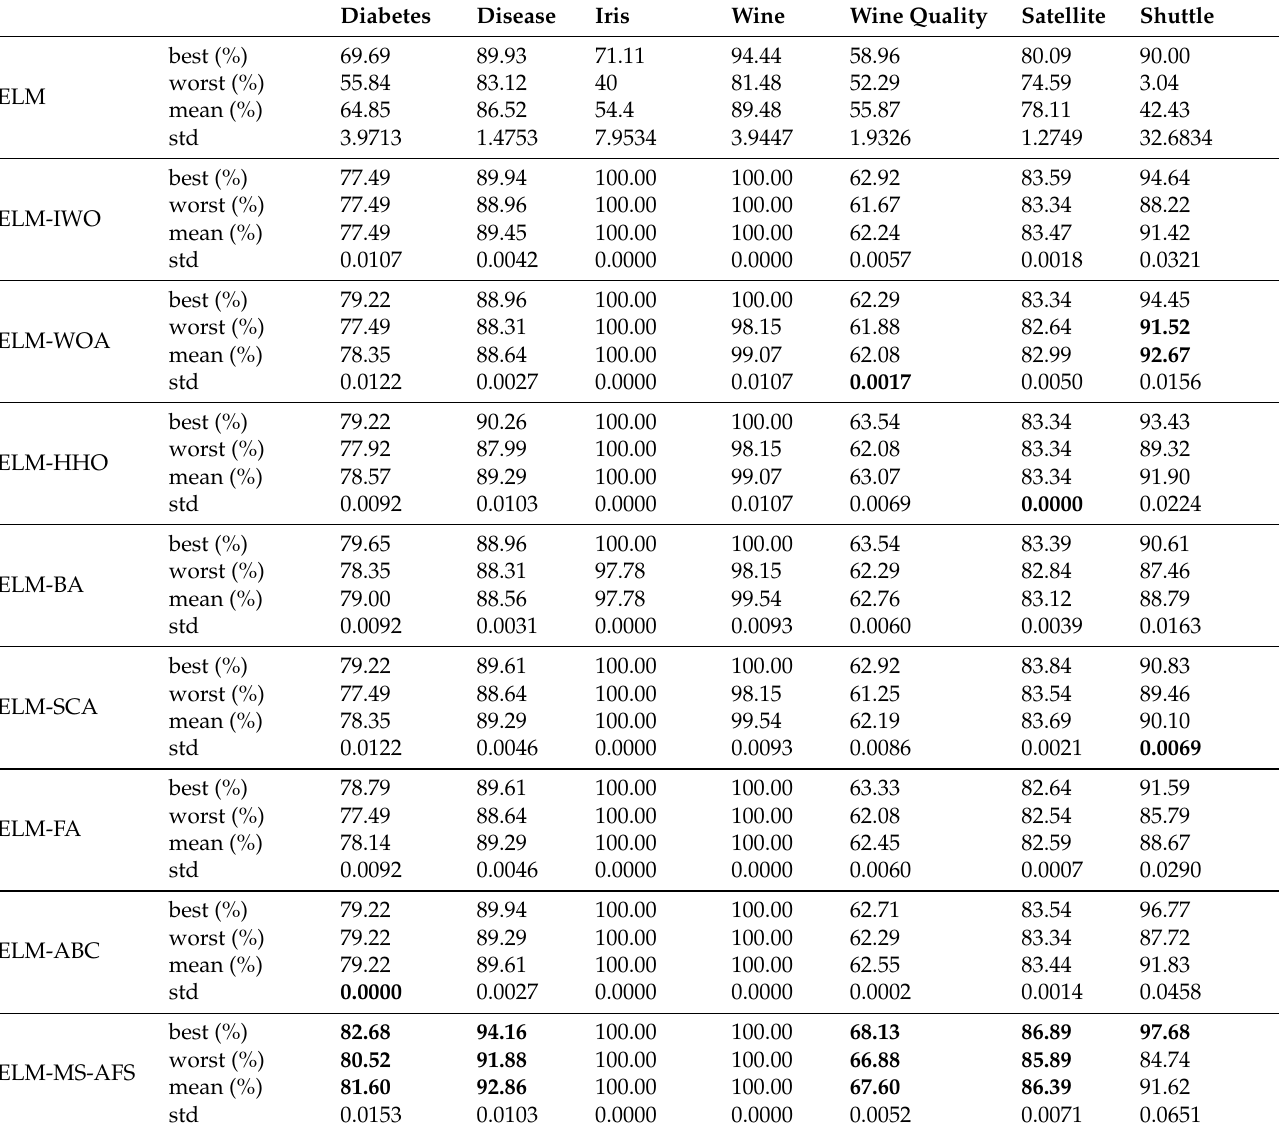
Table 3. Accuracy comparative analysis for simulations with 60 neurons.